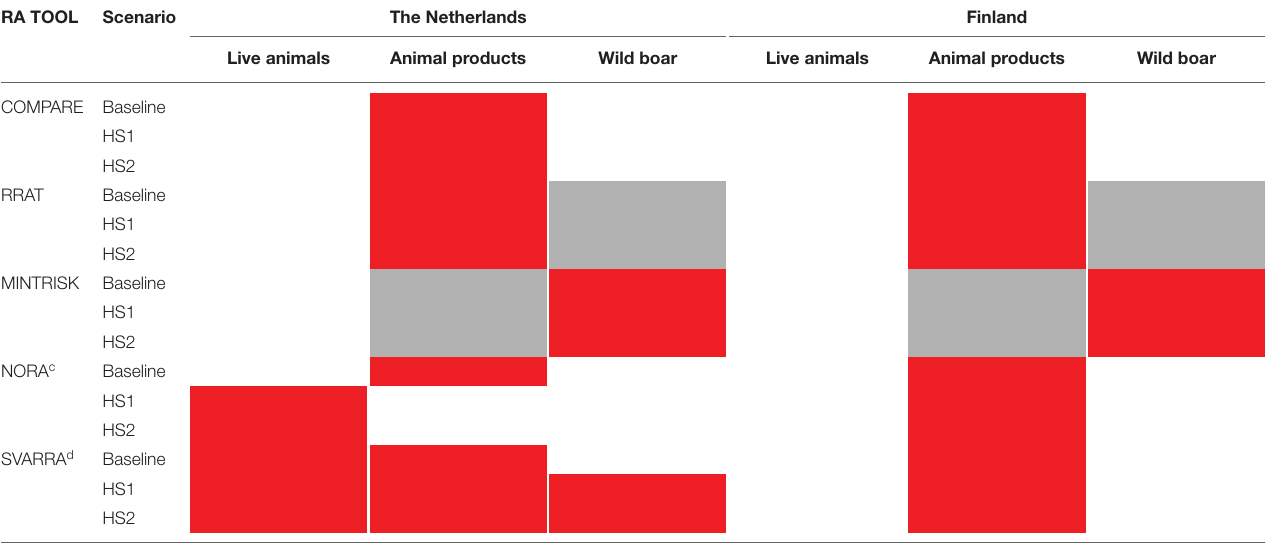
TABLE 4 | Pathways contributing most to the ASF incursion risk for each tool a per country and scenario (indicated in red) b